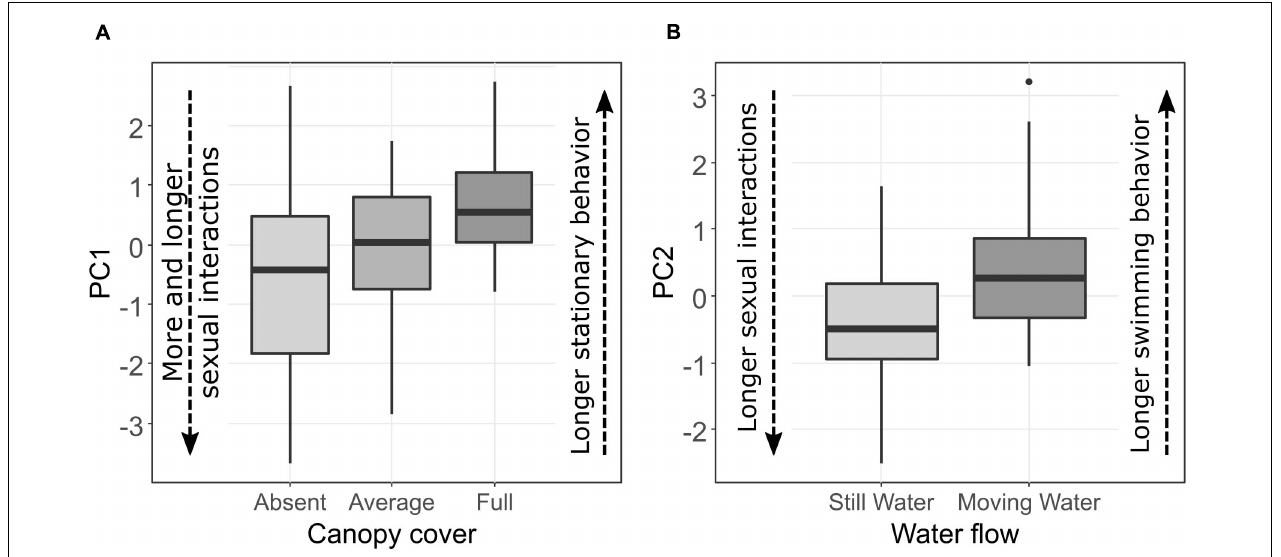
FIGURE 1 | The boxplots represent in (A) the association between PC1 (43% of variance explained) and canopy cover, where duration and number of sexual interactions decrease and stationary behavior increases with increasing canopy cover. In (B) the association between PC2 (20% of variance explained) and water flow, where duration of sexual interactions increases and time spent swimming decreases in still water compared to moving water.